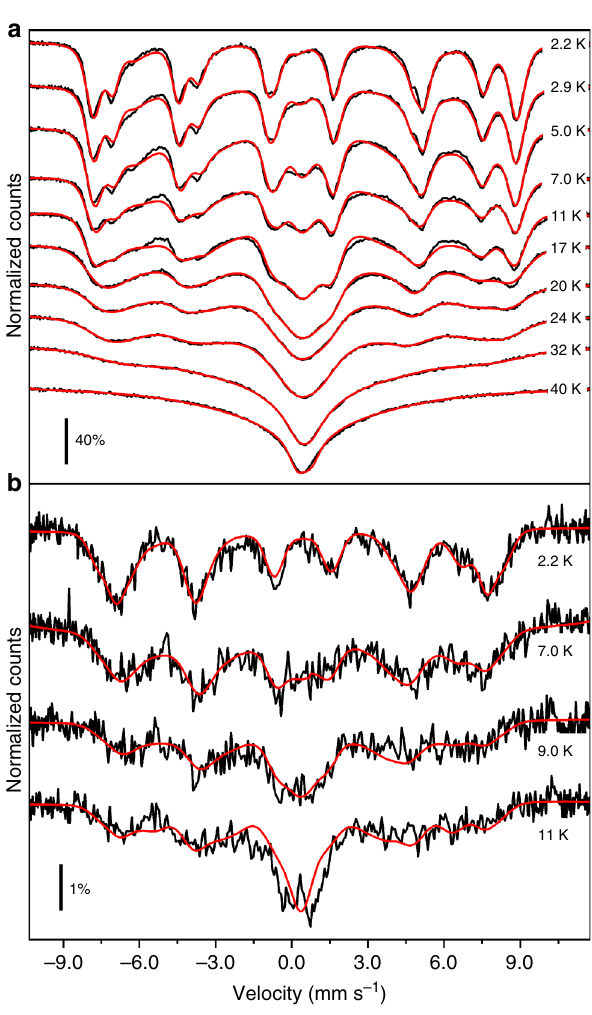
Fig. 2 Mössbauer spectra of the dropcast and monolayer samples for various temperatures. a Experimental spectra (black lines) of the Fe 4 dropcast sample and best fi t curves (red lines). b Experimental spectra (black lines) of the Fe 4 monolayer sample and best fi t curves (red lines). The velocity axis values are relative to the α -Fe standard Mössbauer time window, so that the measured hyper fi ne fi elds